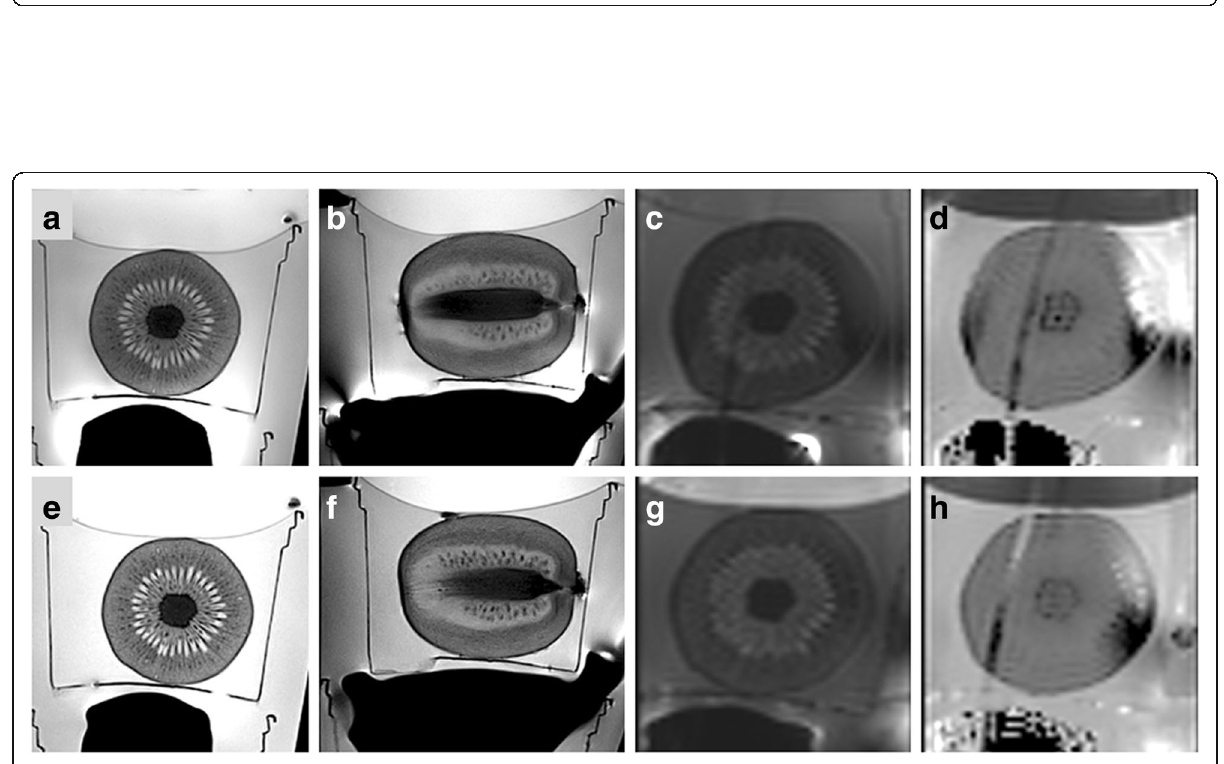
Fig. 3 Biparametric magnetic resonance imaging at 3.0 T of a green Hayward kiwifruit ( Actinidia deliciosa ) was performed at site 1 both without ( a – d ) and with an endo-rectal coil ( e – h ) included in a multichannel phased-array coil system: axial ( a , e ) and sagittal ( b , f ) T2-weighted imaging (T2WI), axial diffusion-weighted imaging with a b value of 800 s/mm 2 ( c , g ), and corresponding apparent diffusion coefficient map ( d , h ) obtained with a reduced field of view